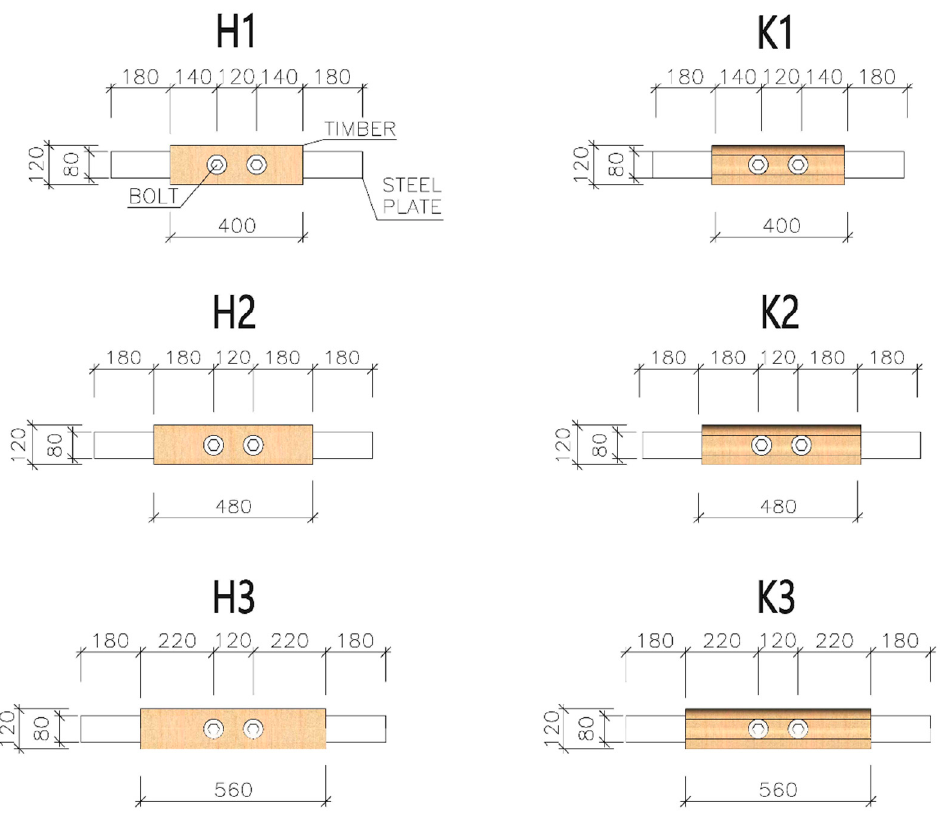
Figure 3. Types of specimens for tension tests parallel to the grain.